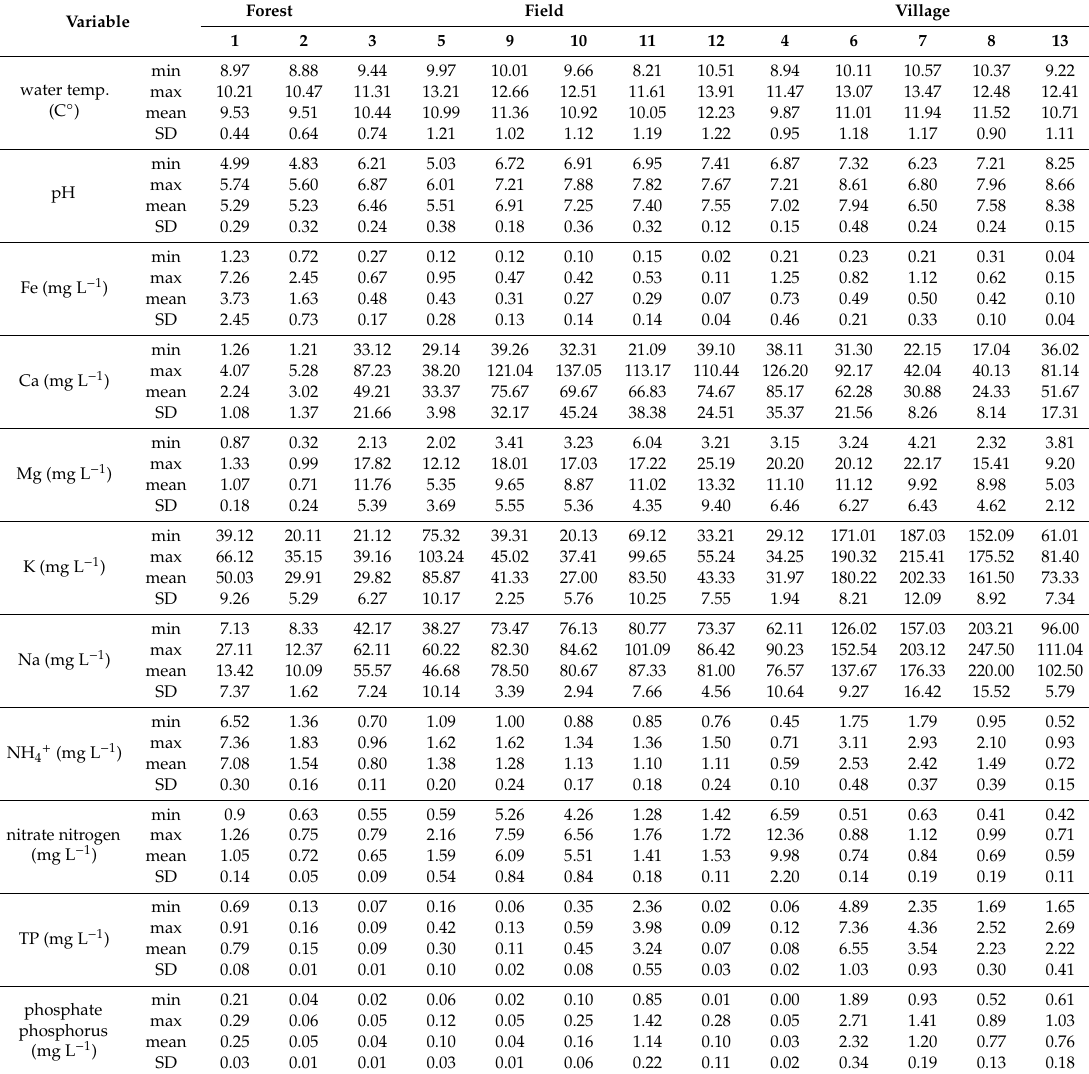
Table A2. The physicochemical parameters of the water in ponds. Variable water temp. (C ◦